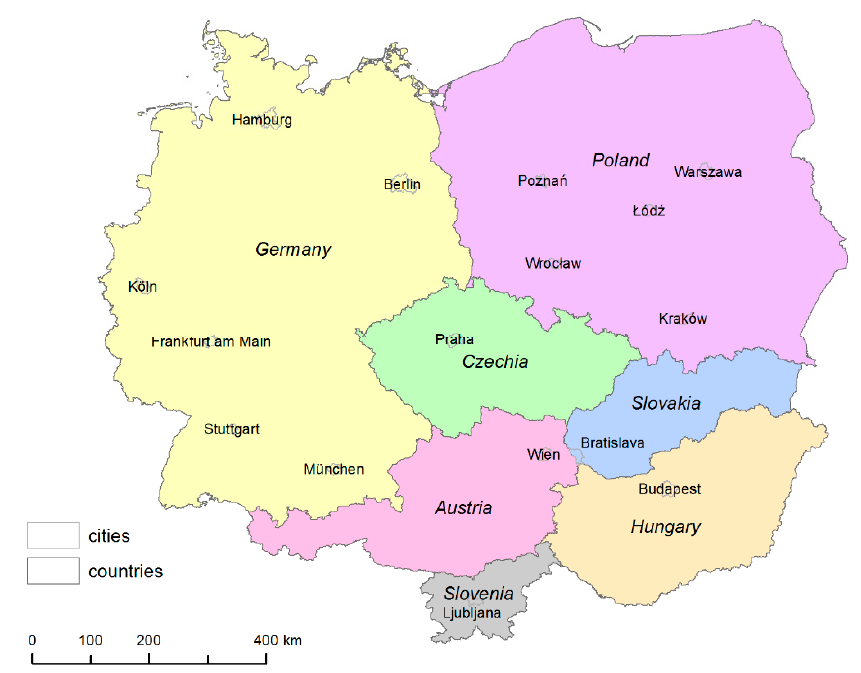
Figure 2. The Central European region under study. Source: © EuroGeographics for the administrative boundaries, European Commission, Eurostat/GISCO.